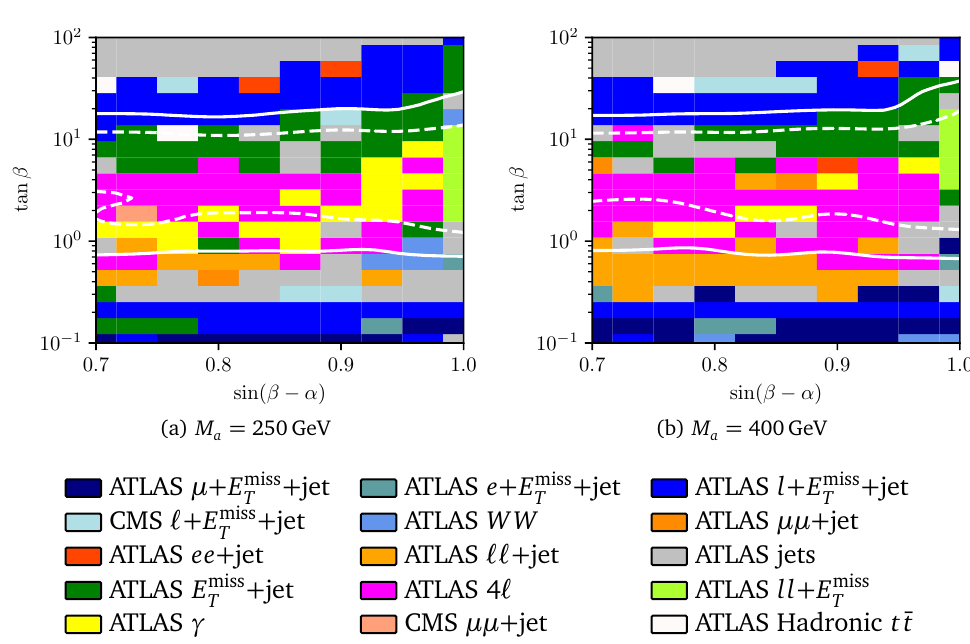
Figure 8: Moving away from the alignment limit of sin ( β − α ) = 1. All other parame- ters are as given in Table 1. The 95% (68%) excluded contours are indicated by solid (dashed) white lines; the colours indicate the most sensitive set of